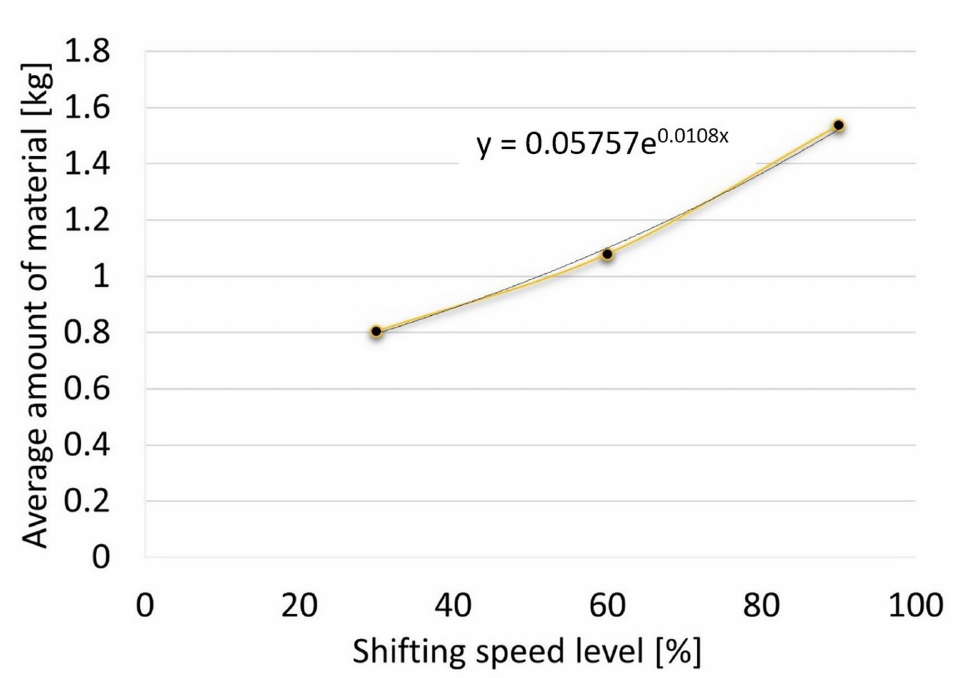
Figure 14. Dependence of the average value for amount of the transported material, STEEL GRIT GH50, in the case of one stroke on the adjusted shifting speed